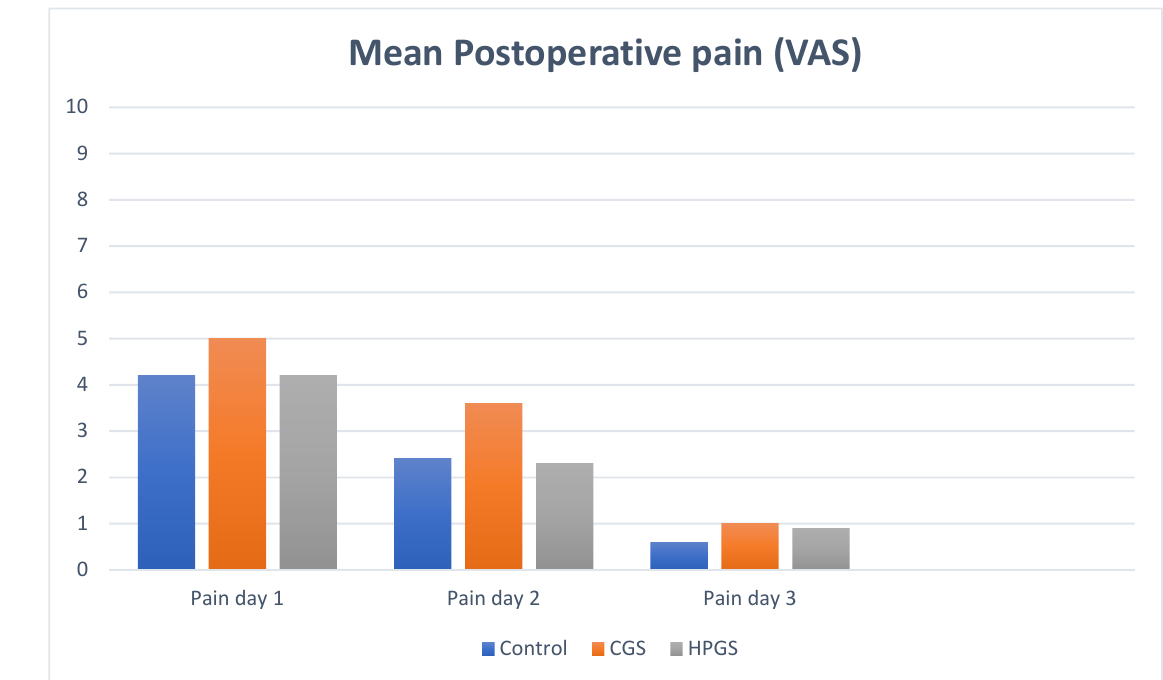
Figure 5. Evolution of the mean pain measured in 3 postoperative days for three groups of treatment. Abbreviations: VAS, visual analog scale; GS, conventional gelatin sponge; HPGS, high po-